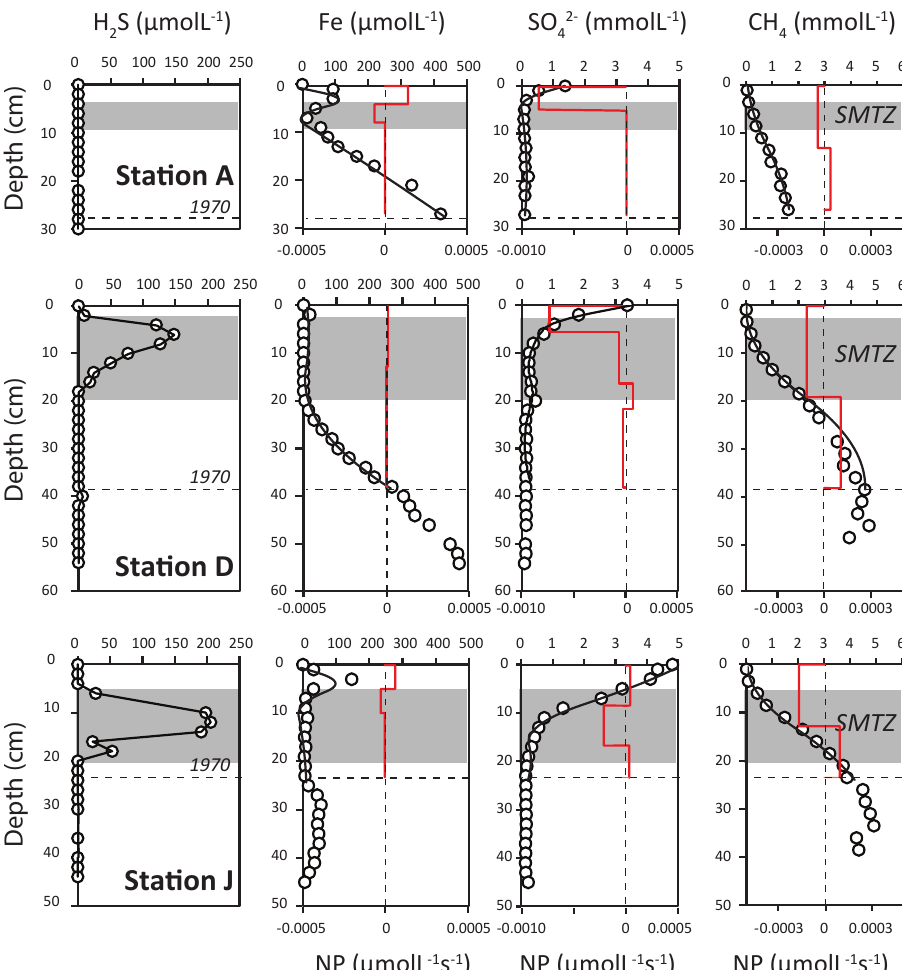
Figure 8. Pore water data from Stations A, D and J. Hydrogen sulfide (H 2 S) data are connected point by point. The depth of the H 2 S peak is used to define the sulfate-methane transition (SMTZ). Where no H 2 S is present (i.e., at Station A), the SMTZ is defined by the corresponding minimum in pore water Fe. For all other parameters, parabolic best fit lines were generated using PROFILE. These fits were used to determine the zones, and instantaneous rates, of net production (NP) of each species within the depth interval 1970–2015 (red lines). The rate of net production is determined from the change in gradient of the concentration as described by Eq. (8). Negative rates indicate net